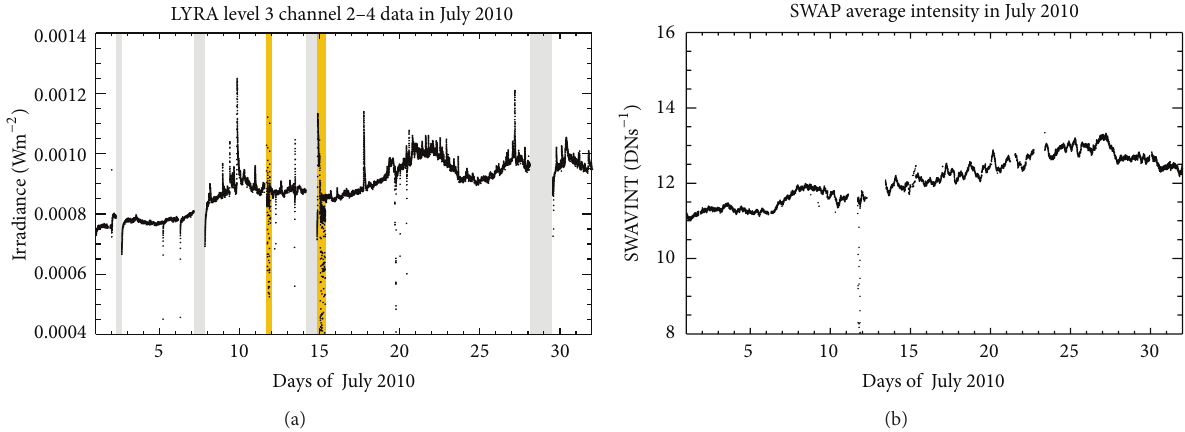
Figure 5: SWAVINT data variation (b) and LYRA level 3 channel 2–4 data variation (a) in July 2010 with calibration campaign data (grey bands) and special campaign data (orange bands) indicated. The other downward spikes are a result of the stabilization effect after the spacecraft off-pointings required by the SWAP calibration campaigns.